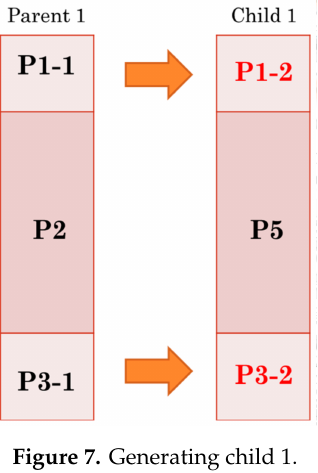
Figure 7. Generating child 1.